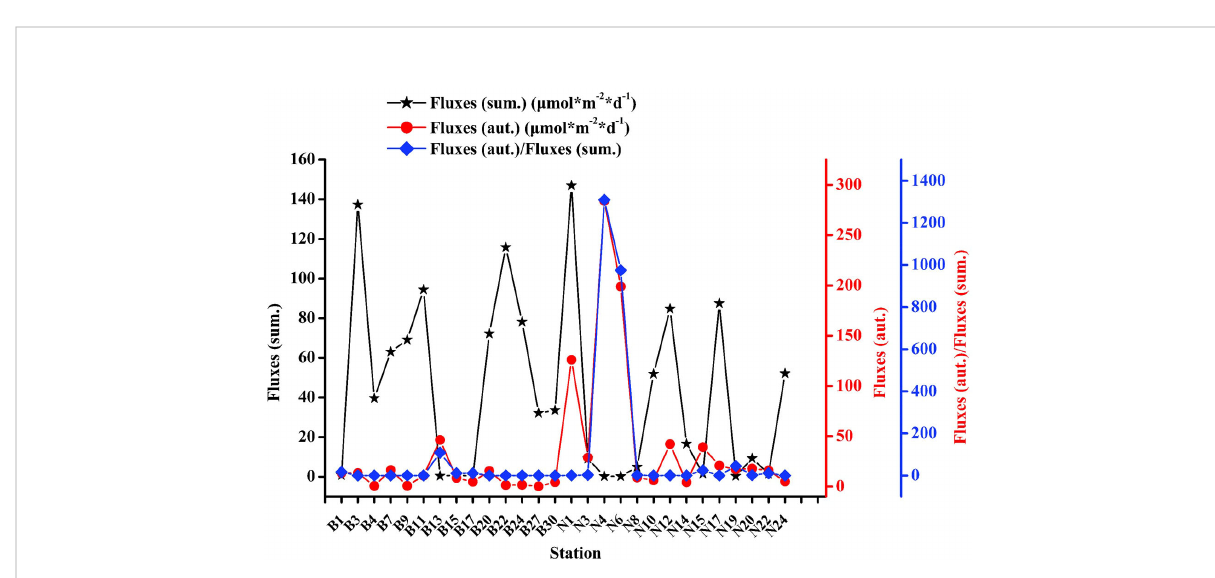
FIGURE 7 Air-to-sea fl ux curves and the ratio of DMS concentrations in BS and NYS in summer and autumn.